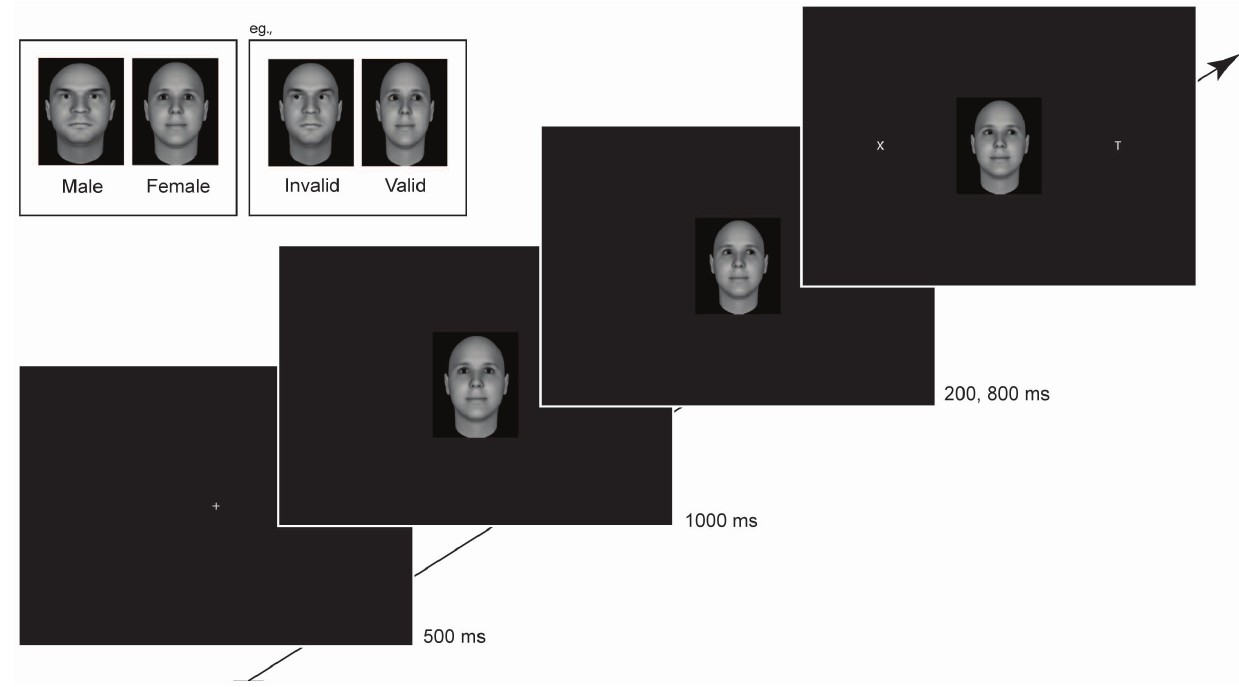
Figure 1. Experimental design. Top of the figure: The male (right) and female (left) face with a straight ahead gaze, a gaze to the right and a gaze to the left. Bottom of the figure: The used gaze cuing task that consists of a fixation point which was visible for 500 ms, a (male/female) face with a straight ahead gaze appears after the fixation point for 1000 ms, then the gaze of the (male/female) face looks to the left, right or straight ahead (control condition, no change) and the target letter ‘L’ or ‘T’ appears after 200 or 800 ms (SOA) and stays visible until the participants press the up (‘T’) or down (‘L’) arrow on the keyboard.